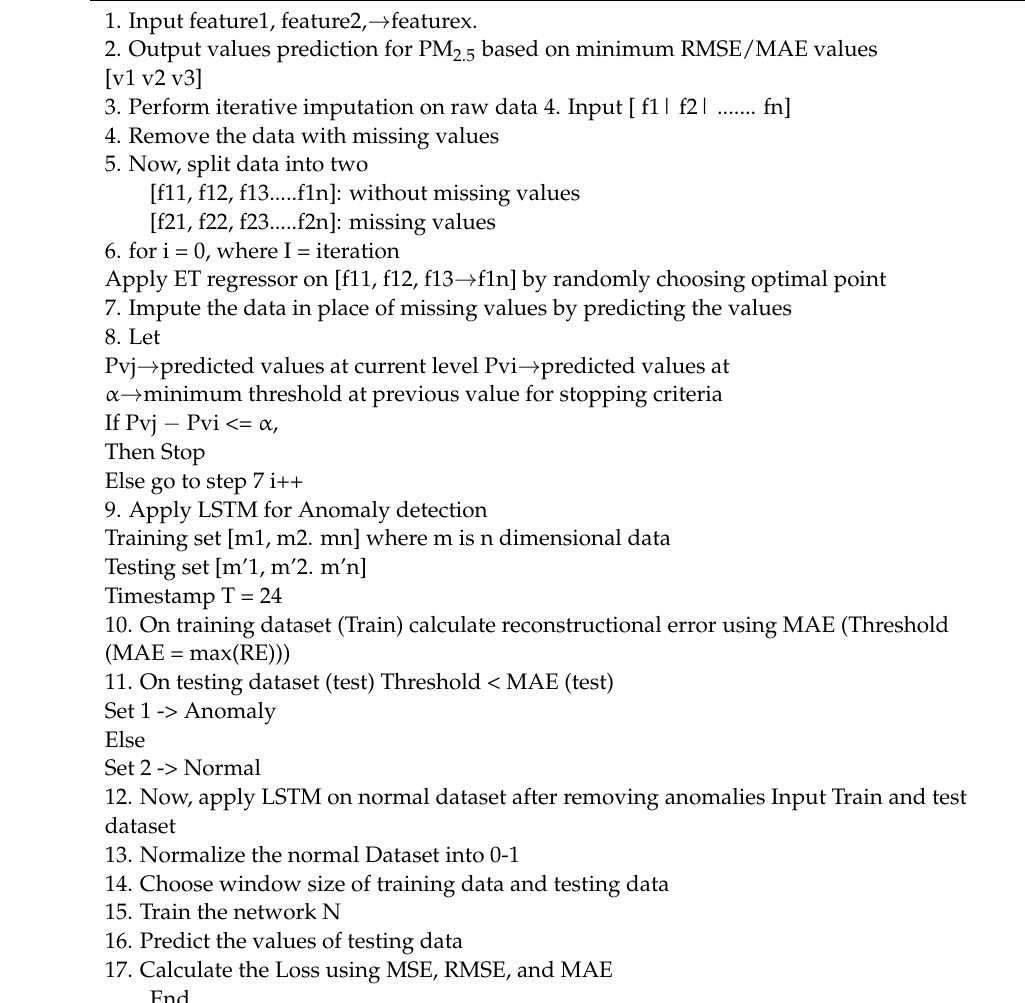
Algorithm 1. Algorithm for Proposed